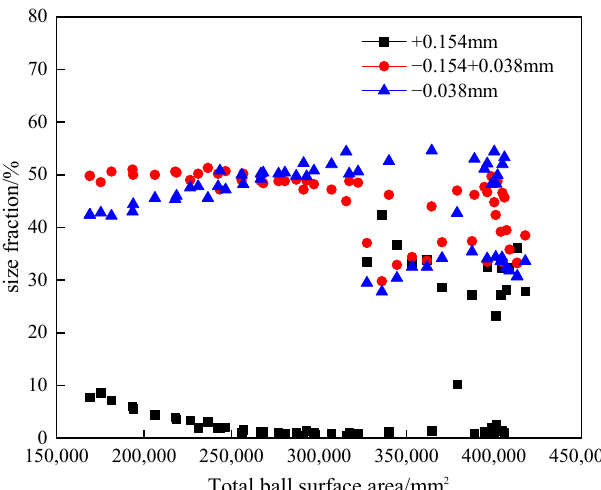
Figure 5. Relationship of the yields of the size fractions in grinding products with the total surface area of the grinding